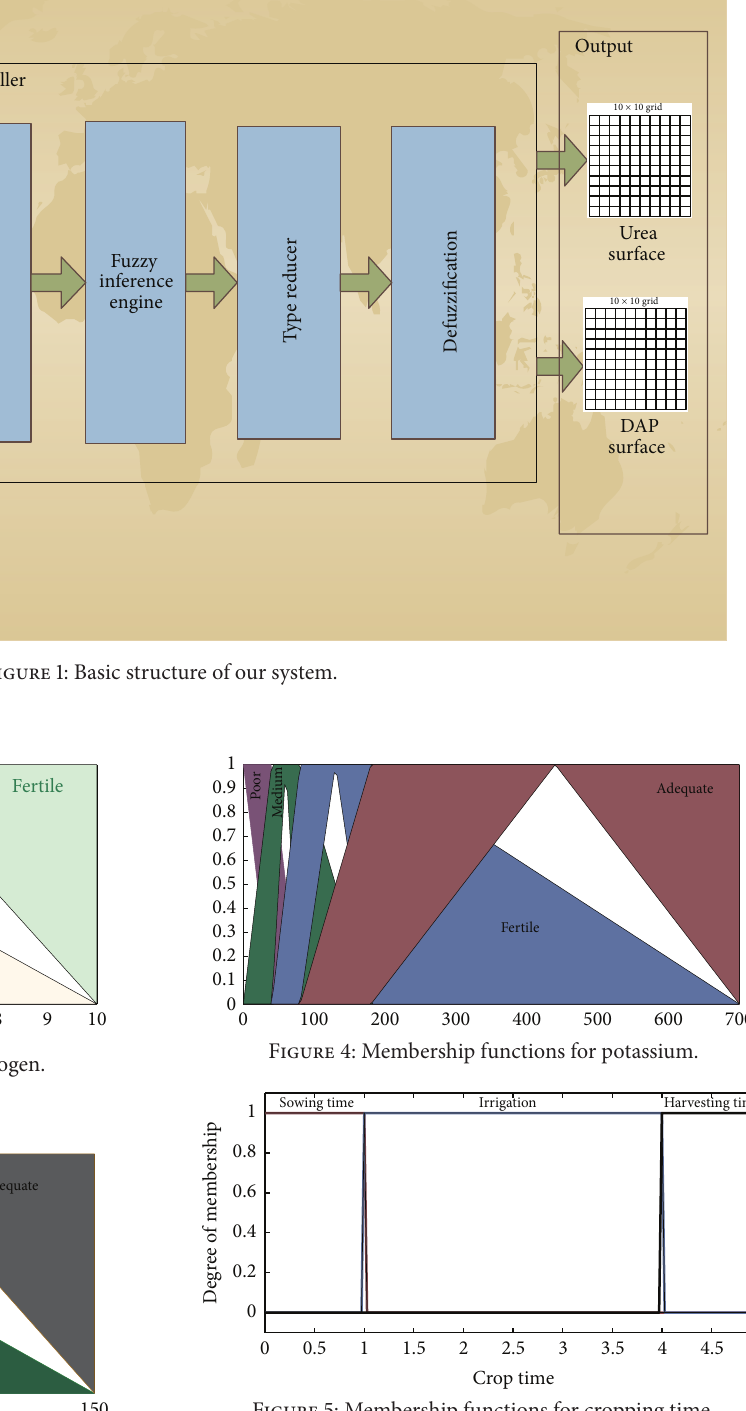
Figure 5: Membership functions for cropping